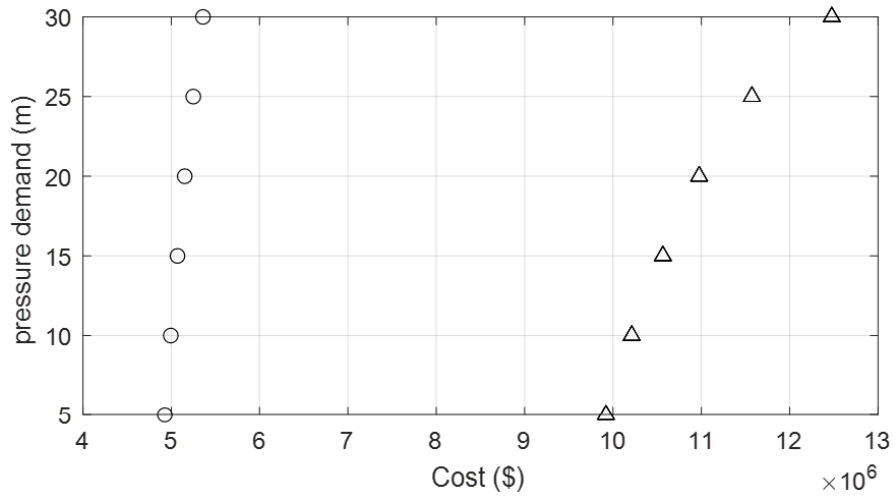
Figure 7. Cost vs. minimum pressure-demand tradeoff curve for Fossolo network.